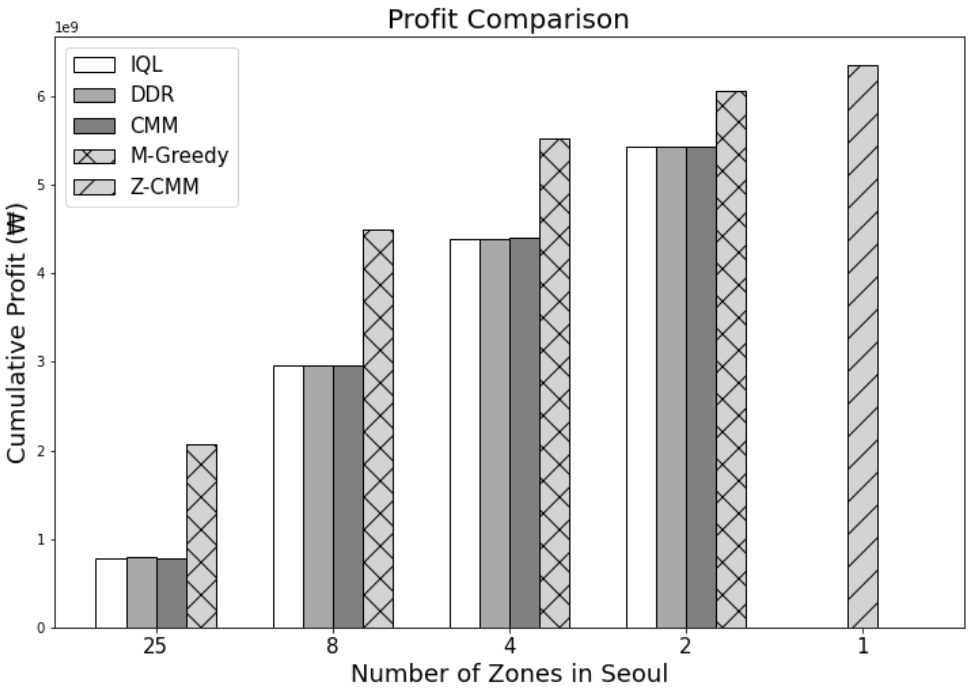
Figure 10. Comparison of the cumulative profit by each methodology during 24 h. The Z-CMM methodology recorded the highest profit.